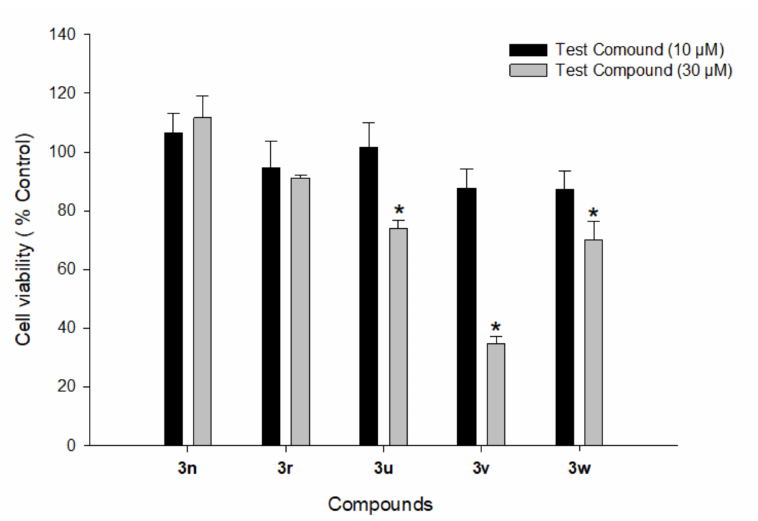
Figure 11. Effects of compounds 3n , 3r, and 3u – w on the viability of PC12 cells. PC12 cells were treated with test compounds at 10 and 30 µ M for 24 h. MTT assays were performed as described in the Materials and Methods section. Data are expressed as the mean ± SEM of at least three independent experiments. * p < 0.05 vs. vehicle-treated control cells.